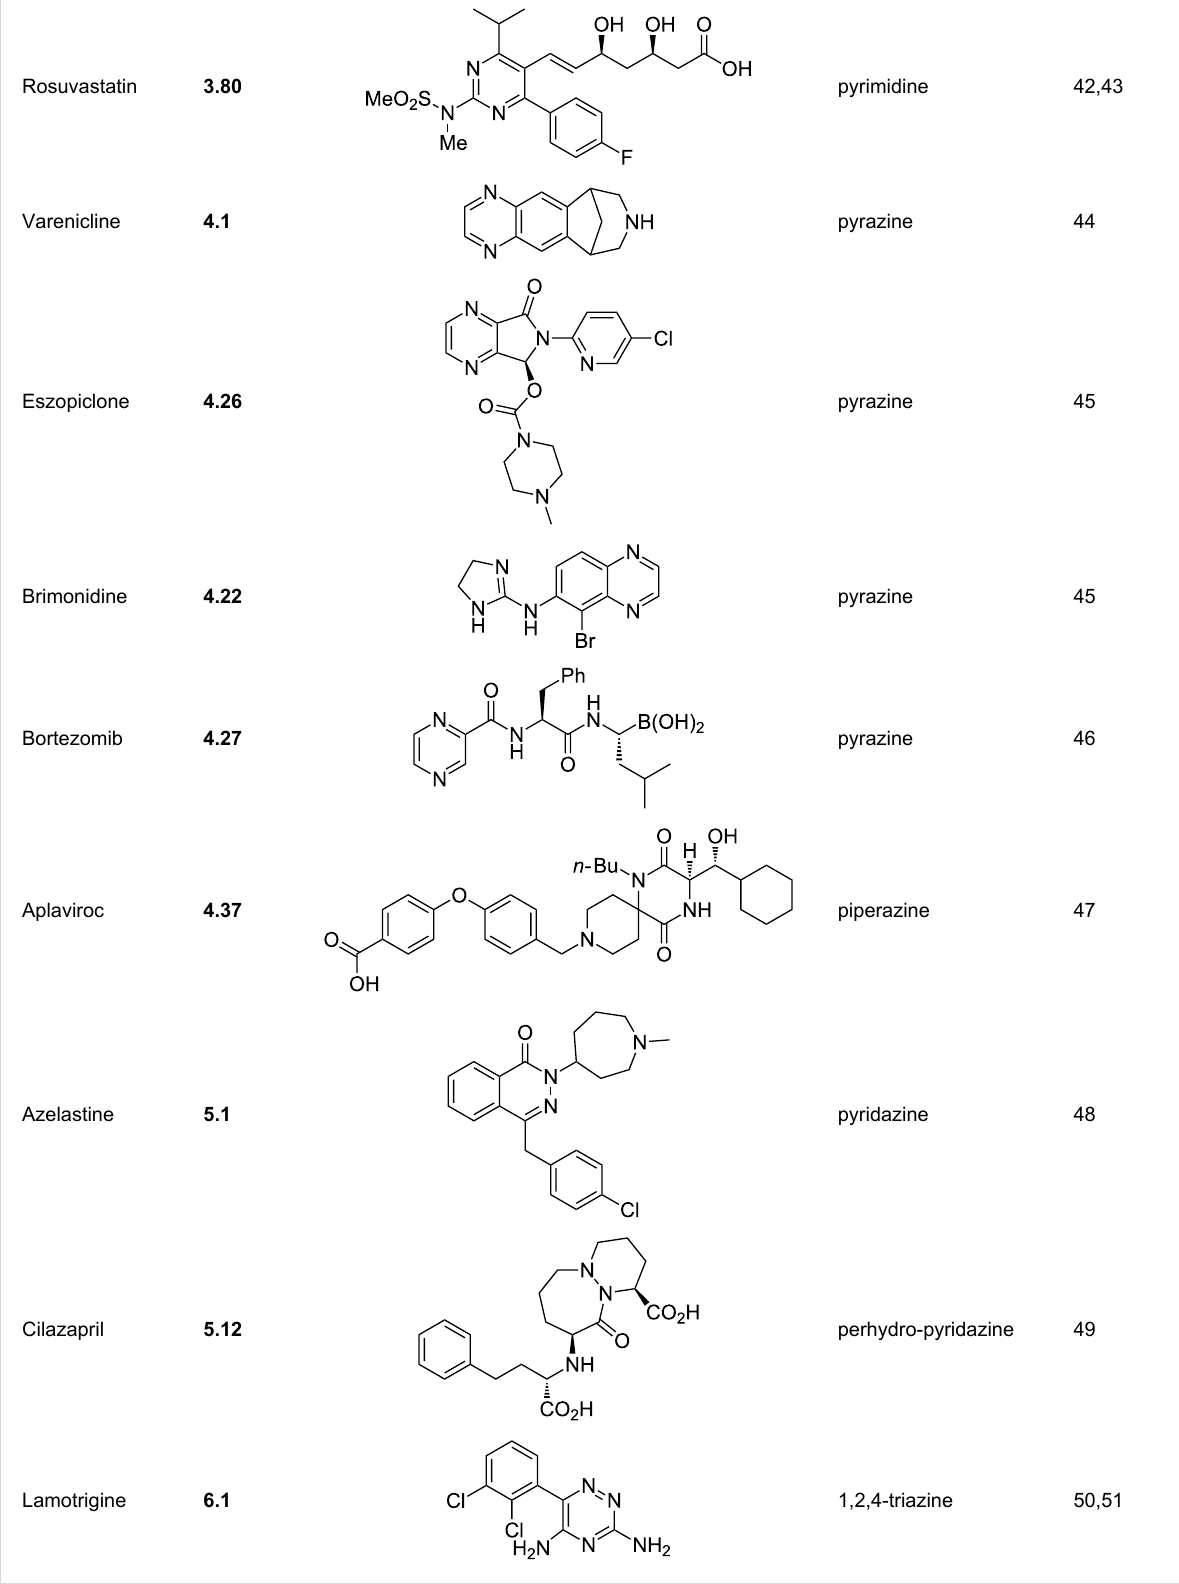
Table 1: Chemical structures of the heterocyclic compounds discussed in this review. (continued)